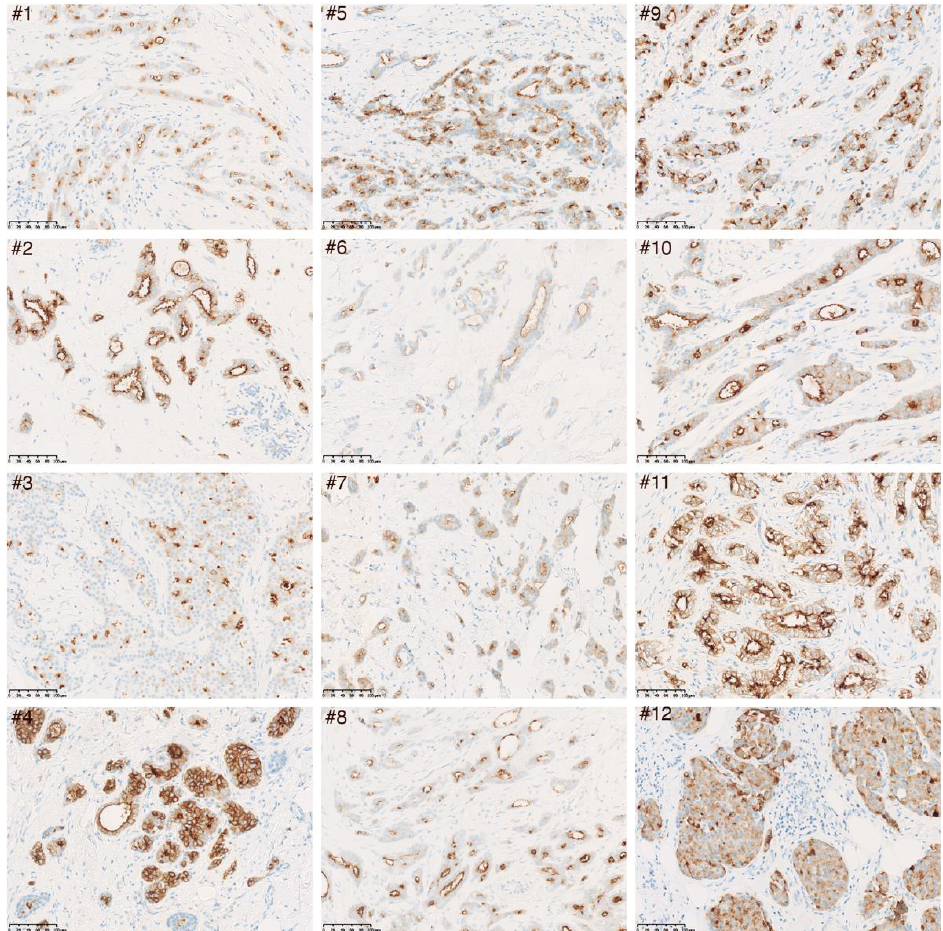
Figure 3. Immunohistochemical analysis of LRP2 protein expression in 12 luminal A invasive ductal carcinomas. Representative images of sections from 12 different invasive ductal carcinomas labeled with a monoclonal mouse anti-human LRP2 antibody (1:100) are shown. Magnification: 20×. Scale bar: 100 µm. Similar images from labeling of sections from the same 12 luminal A invasive ductal carcinomas with a polyclonal rabbit anti-human LRP2 antibody are shown in Figure S6.